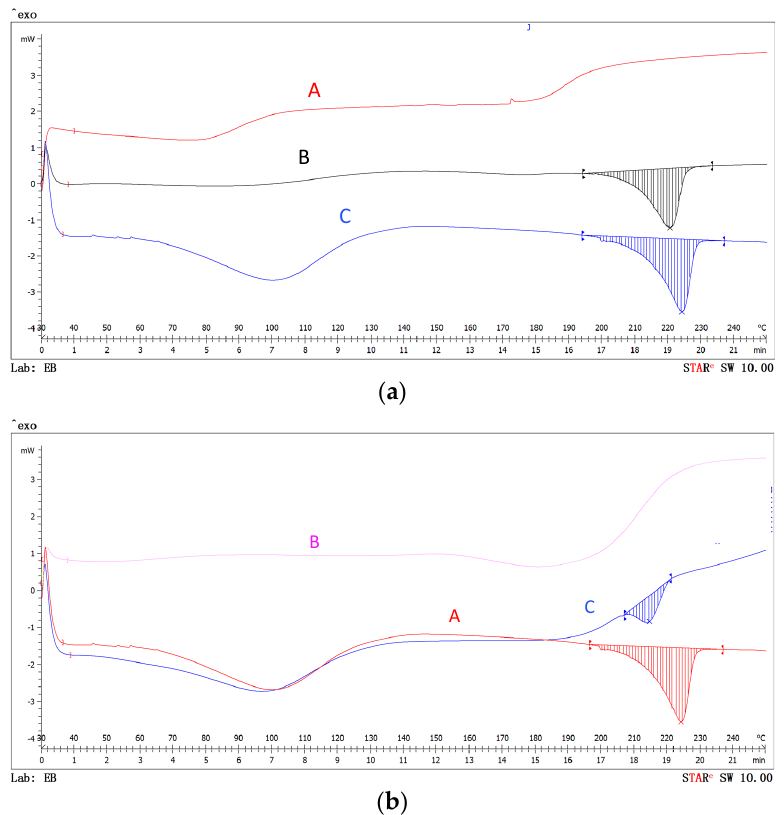
Figure 9. DSC of nanofibers. ( a ) Sage: (A) sage essential oil; (B) PVA nanofibers; (C) PVA − sage nanofibers. ( b ) Thyme (A) thyme essential oil; (B) PVA nanofibers; (C) PVA − thyme nanofibers.